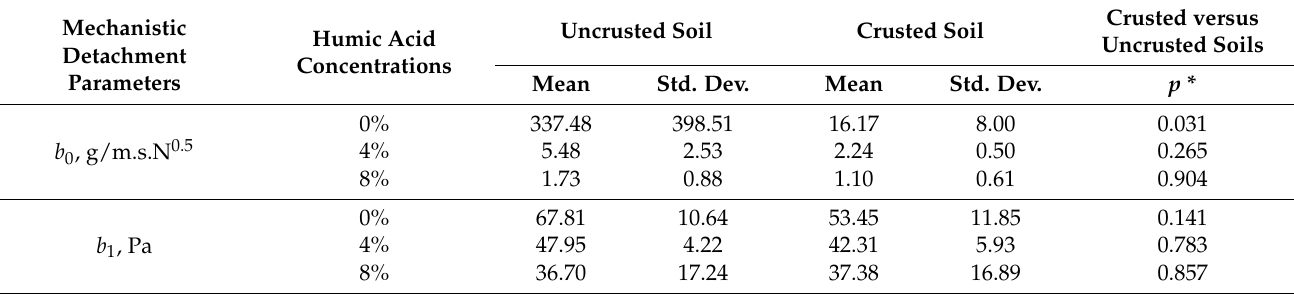
Table 2. Statistical analysis of the influence of curing times (1 week, 2 weeks, and 3 weeks) using paired t -test ANOVA on mechanistic detachment parameters ( b 0 and b 1 ) for undisturbed soil specimens ( n = 36) of crusted and uncrusted soils at different humic acid concentrations (0%, 4%, and